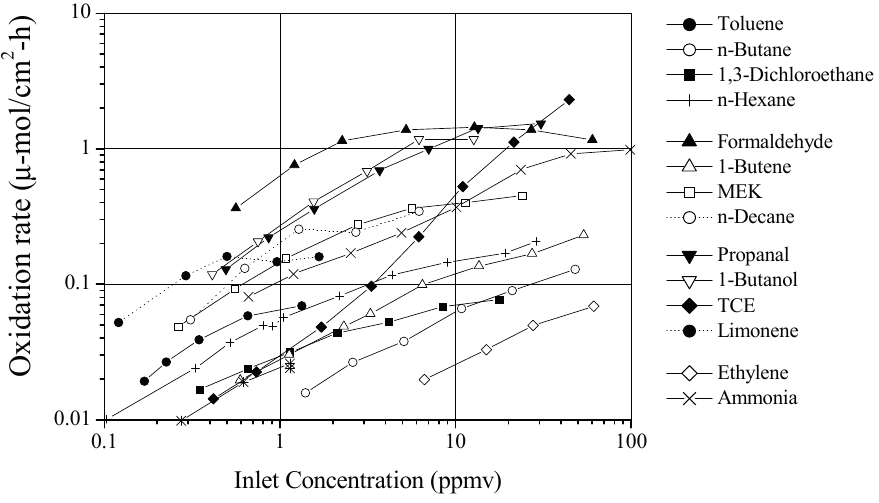
Figure 3. Measured PCO reaction rates for VOCs of interest in indoor air; UV 1-mW/cm 2 , 6000 ppm water level.